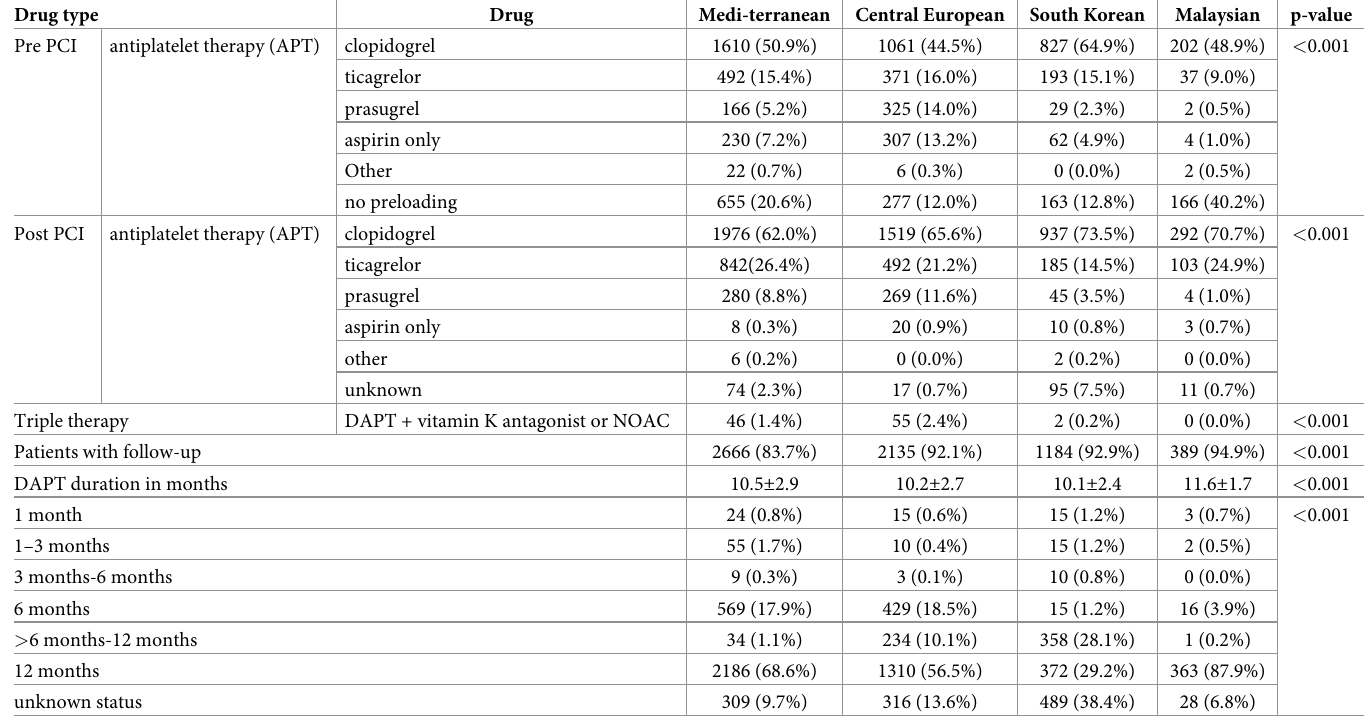
Table 2. Peri-procedural drug therapy and recommended DAPT